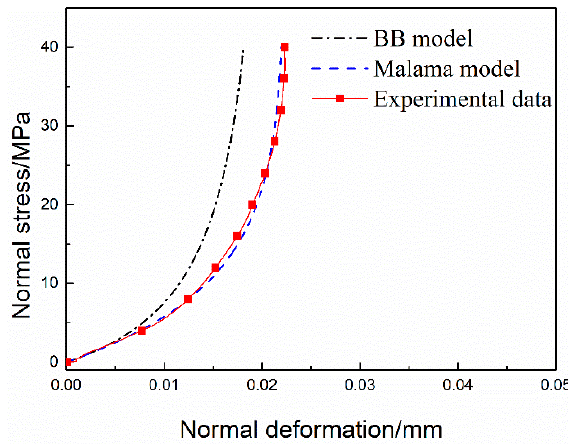
Figure 10. Comparison between experimental data of the joint and previous models for normal deformation versus normal stress. Table 3. The parameters of the joint derived from experimental data.